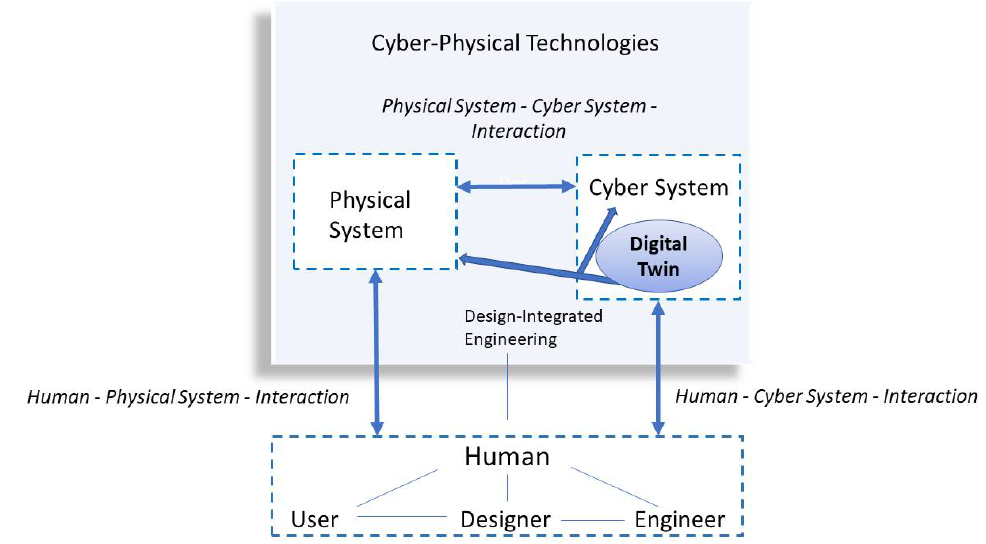
Figure 1. Design-integrated Engineering of Cyber-Physical Systems.